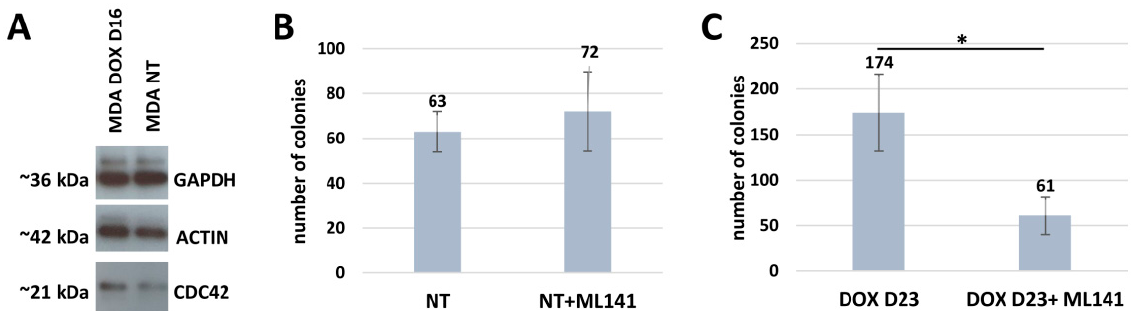
Figure 8. The evaluation of CDC42 by WB and clonogenicity assay: ( A ) Western blot analysis of CDC42 expression in MDA-MB-231 cells before and after DOX treatment. The GAPDH antibody is used as a loading control. ( B , C ) The evaluation of clonogenicity after DOX treatment and CDC42 suppression. ( B ) Clonogenicity of MDA-MB-231 NT cells on day 23 after CDC42 inhibitor, ML141, treatment (100 cells seeded per well). ( C ) Three-fold decrease in the clonogenicity of MDA-MB-231 cells after DOX and CDC42 inhibitor, ML141, treatment (counted from ~1.5 × 10 6 cells initially seeded per flask) on day 23 after treatment evaluated in five independent experiments. * p < 0.05.